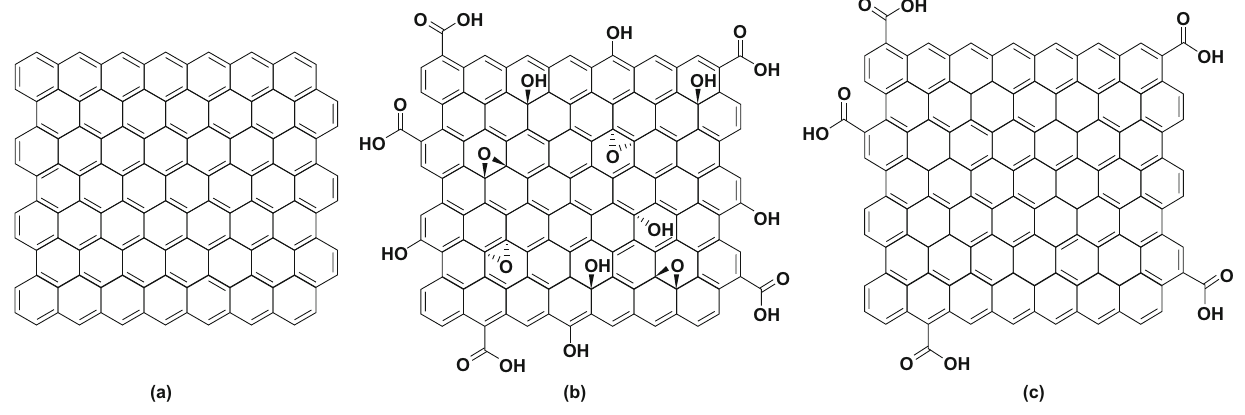
properties. Figure 3 is a schematic representation of chemical structures of graphene, GO and RGO [24]. The analytical techniques such as Raman spectroscopy, trans- mission electron microscopy (TEM), solid-state Fourier transform nuclear magnetic resonance (FT-NMR) spec- troscopy and atomic force microscopy (AFM) are being used to understand the structural properties of GBNs [25].